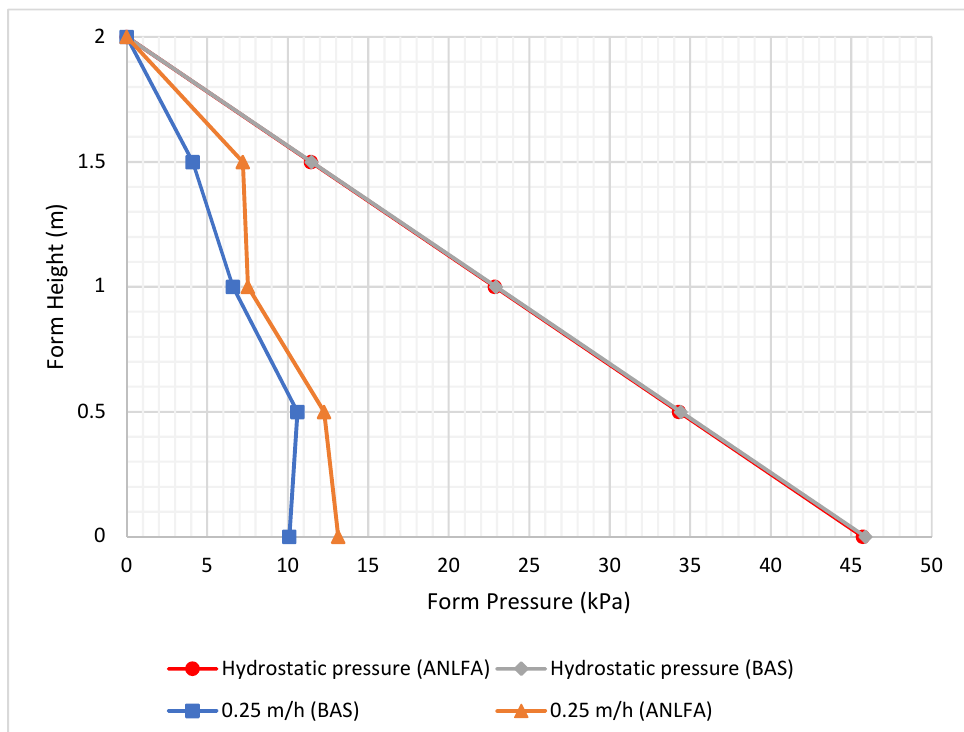
Figure 6. Effect of different types of cement on form pressure.